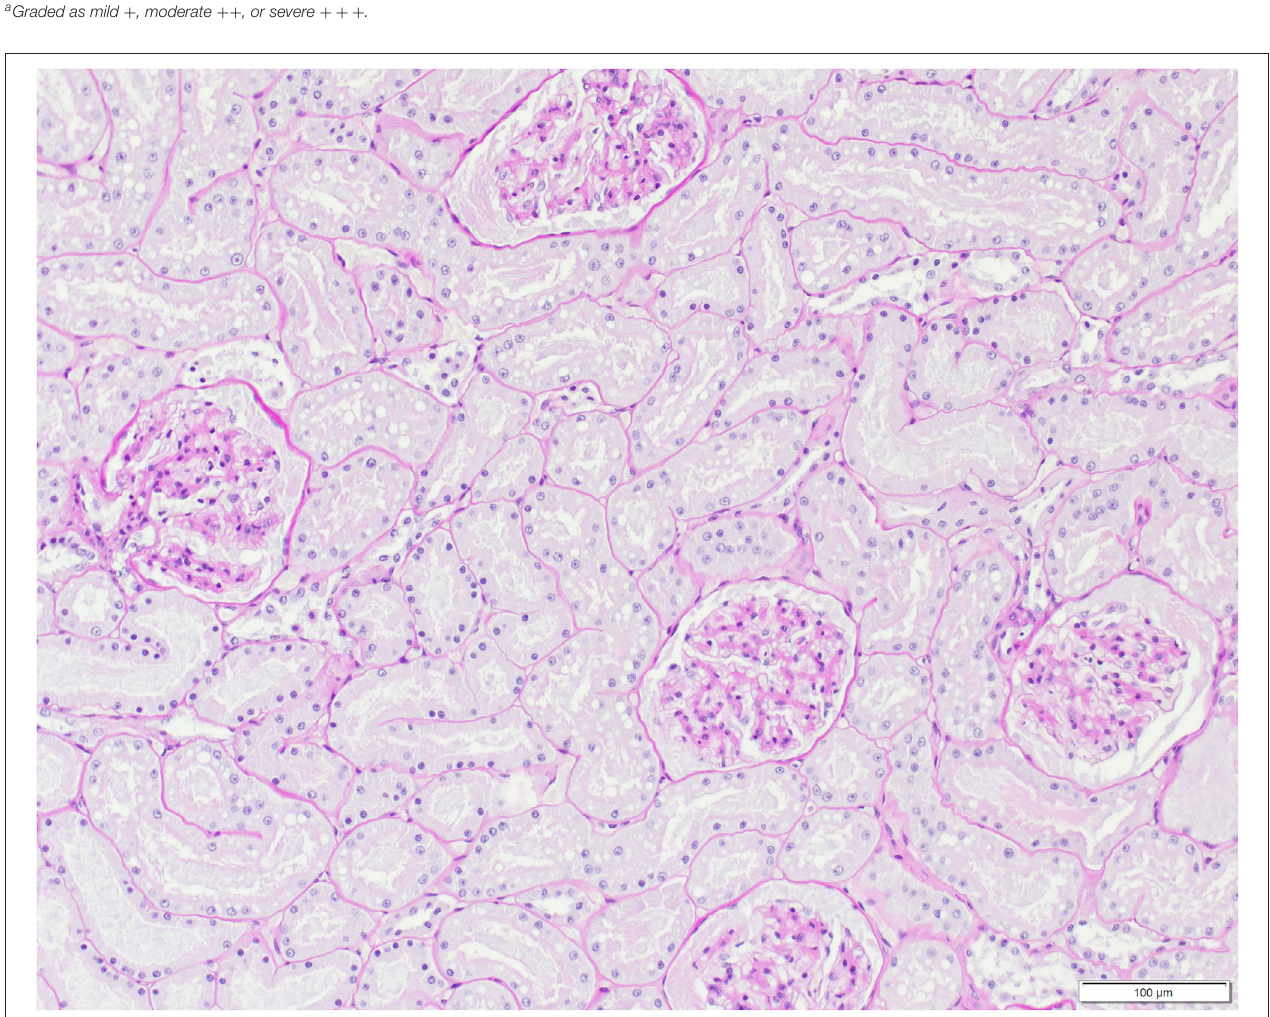
FIGURE 7 | Histological kidney section, Eurasian lynx ( Lynx lynx ), SENI: Presence of eosinophilic material compatible with protein aggregates in glomeruli and tubules, with mild widening of the Bowman’s capsule (mild, multifocal membranous glomerulopathy).